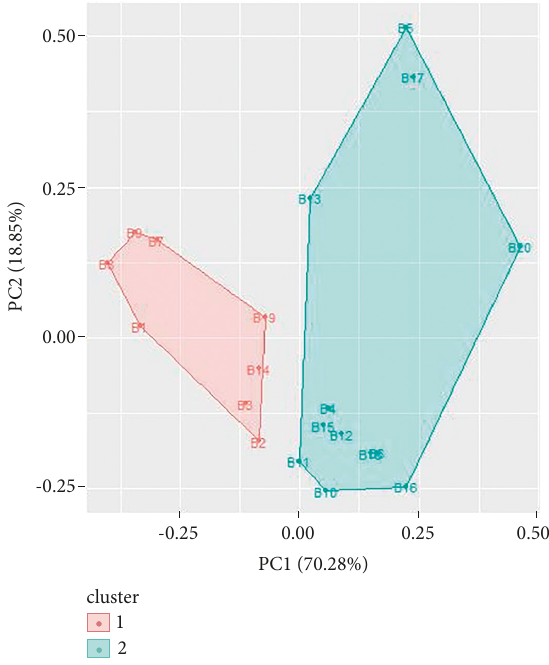
Figure 11: Cluster analysis for UV/Vis spectroscopy data for red ballpoint pen inks.